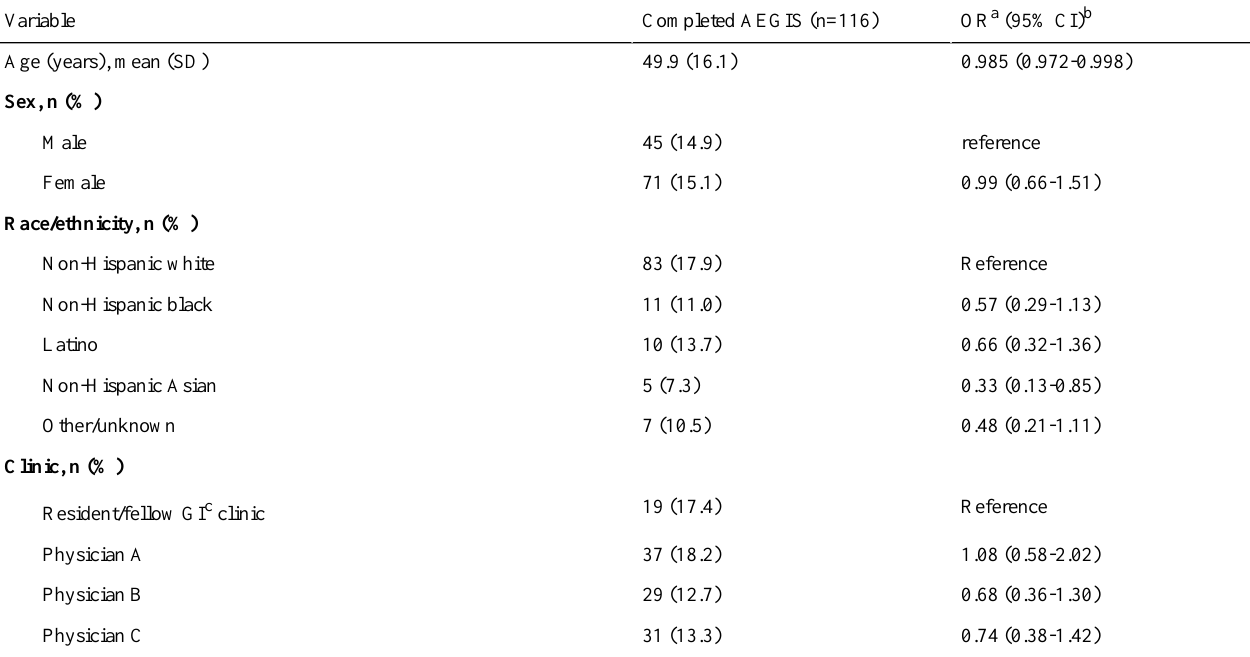
Table 1. Predictors of completing the Automated Evaluation of Gastrointestinal Symptoms (AEGIS) prior to the clinic visit